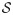
Initial chimerism of neutral donor cells in a healthy, non-preconditioned host.Upper panels depict the level of donor chimerism shortly after a dose of neutral donor cells, S, is injected into the host. Symbols are from numerical integration of Eq (2). The small-dose regime is described by Eq (3) (solid lines for S<103), and the large-dose regime is described by Eq (9) (solid lines for S>102). Lower panels show the accuracy of these approximations when compared to the numerical integration of Eq (2). This error takes the form (approx. − exact)/exact. (a) s* = 10, and (b) s* = 100. The lifetime in the PB, ℓ, is measured in minutes. Remaining parameters are as in Table 1.